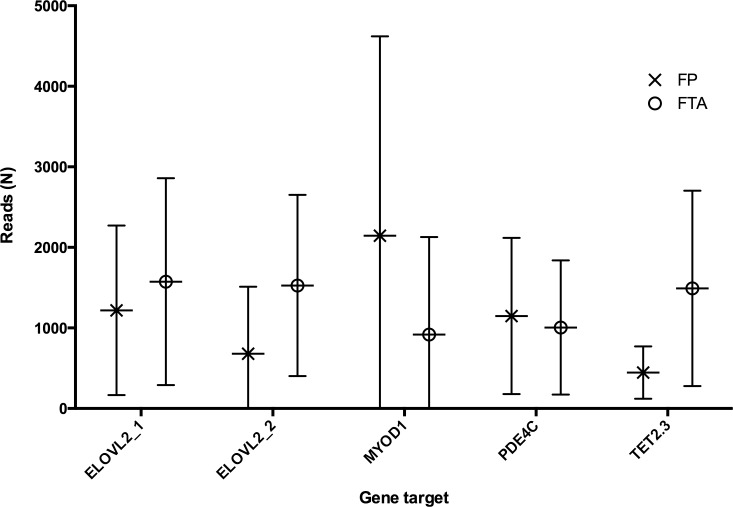
Total reads used to calculate methylation level in gene set 2.The average number of reads varied with each amplicon and tissue type (FP: feather, FTA: whole blood) being investigated. If the total number of reads for a single CpG loci was <100 the result was removed from further analysis.